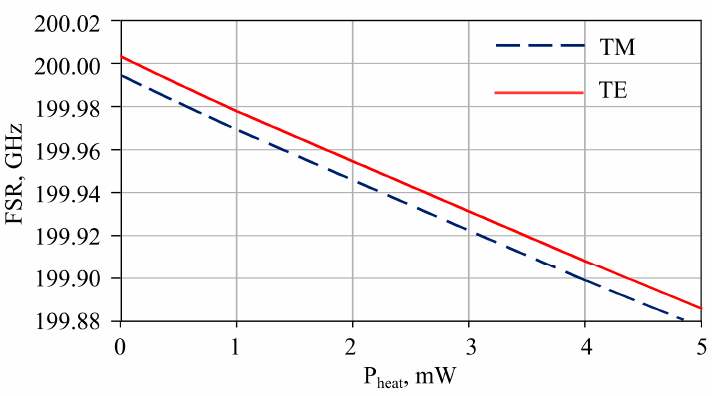
Figure 7. Dependence of FSR on heat power for a microsphere with a diameter of ~328.5 μ m.